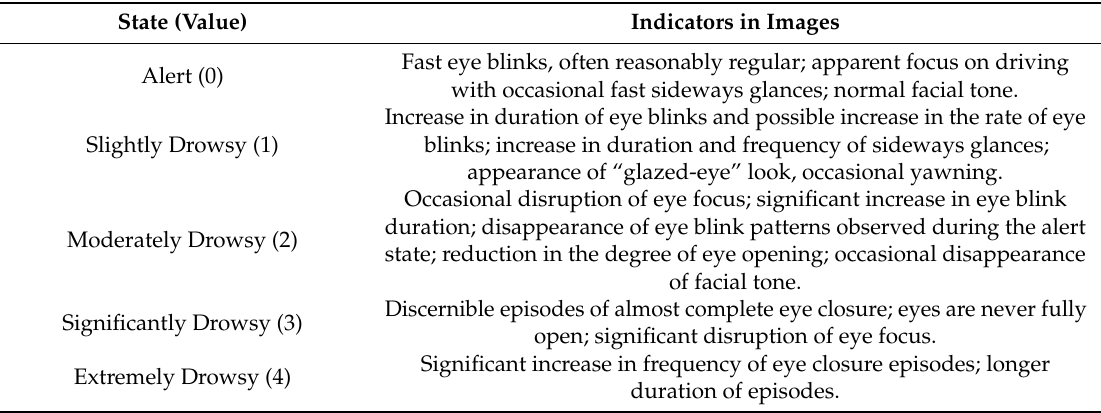
Table 1. Drowsiness level based on facial expression